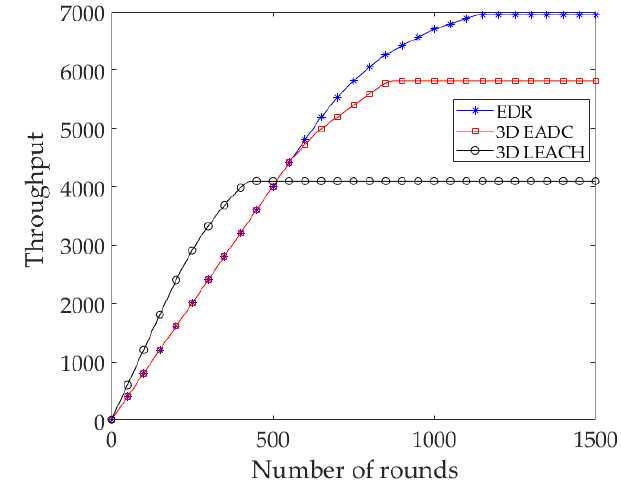
Figure 6. Number of data packets sent to the sink from CH/RC nodes.